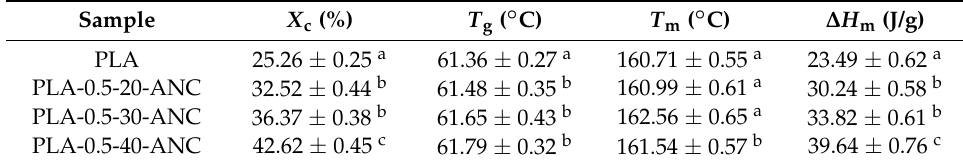
Table 2. Thermal data for the PLA composite films calculated from the DSC second heating scan.